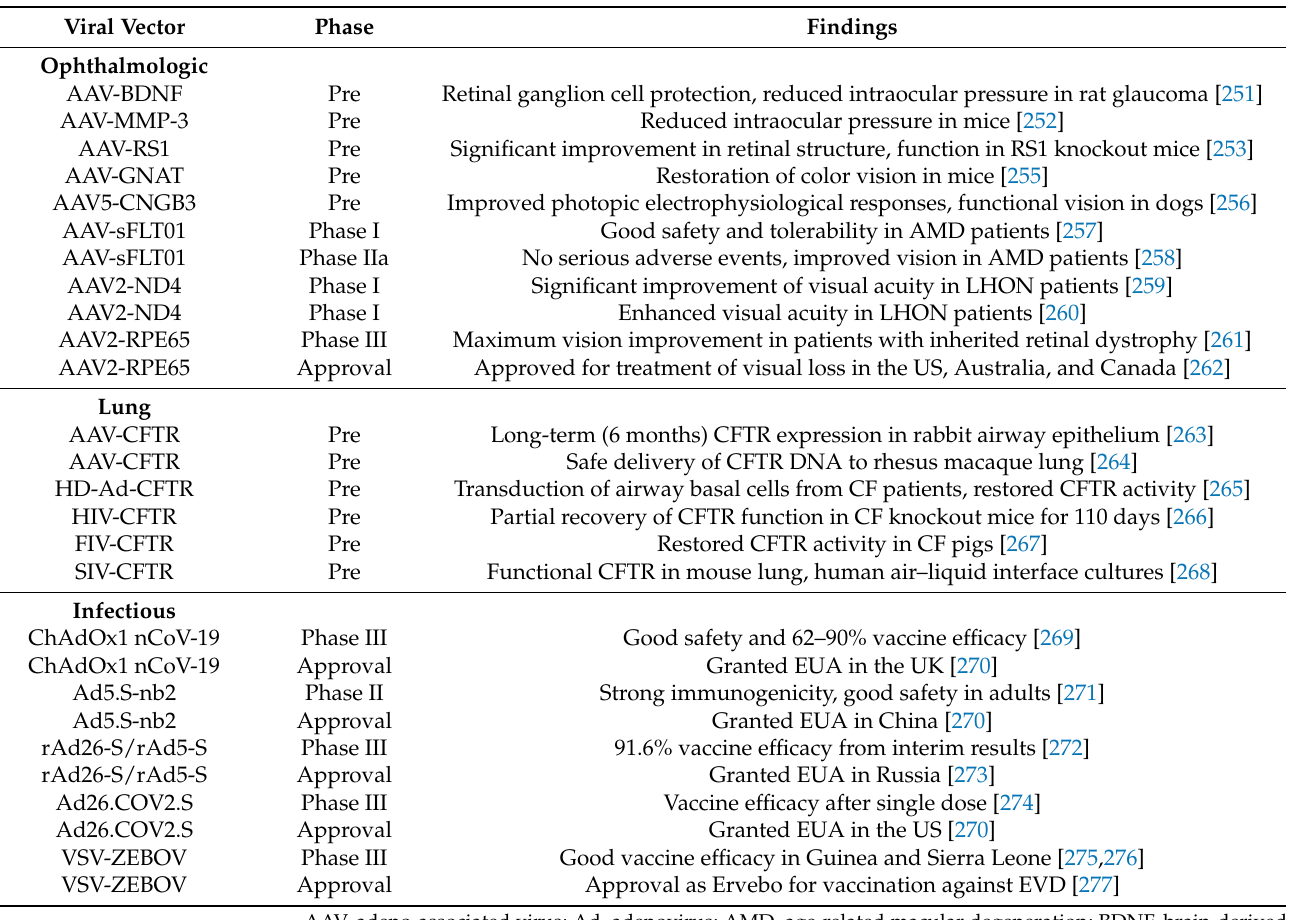
Table 5. Preclinical and clinical examples of viral vectors applied for ophthalmologic and lung diseases, and vaccine development against infectious